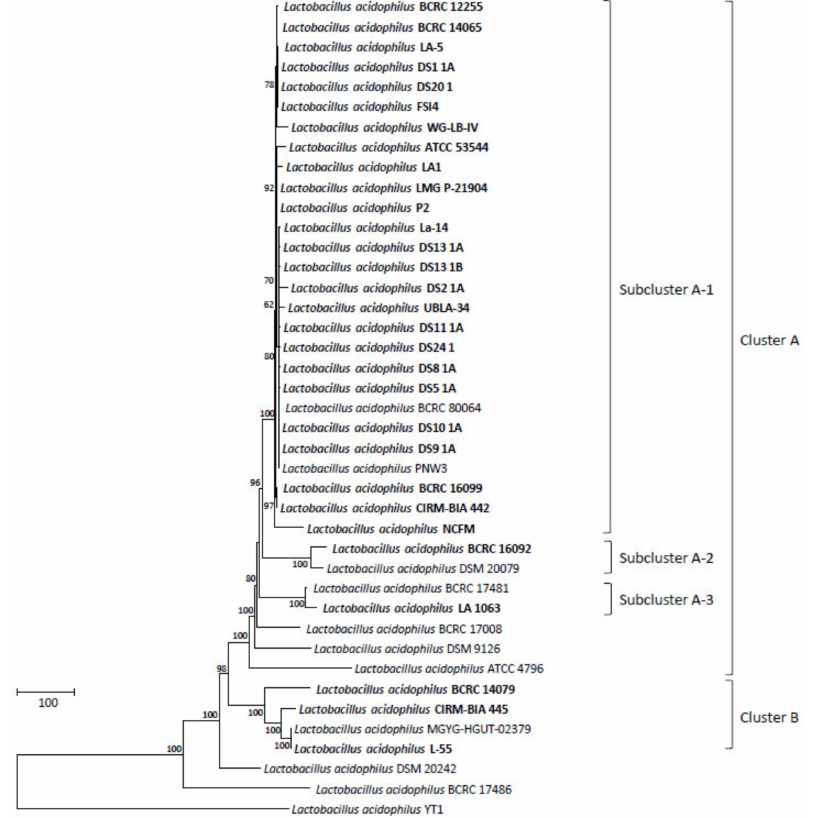
Figure 1. The allele-based neighbor-joining tree constructed with core-genome multilocus sequence-typing (cgMLST) profiles for the 41 Lactobacillus acidophilus strains on the basis of a comparison of 1390 di ff erentiated core genes. The bold letters indicate commercial isolates. Bar, allele